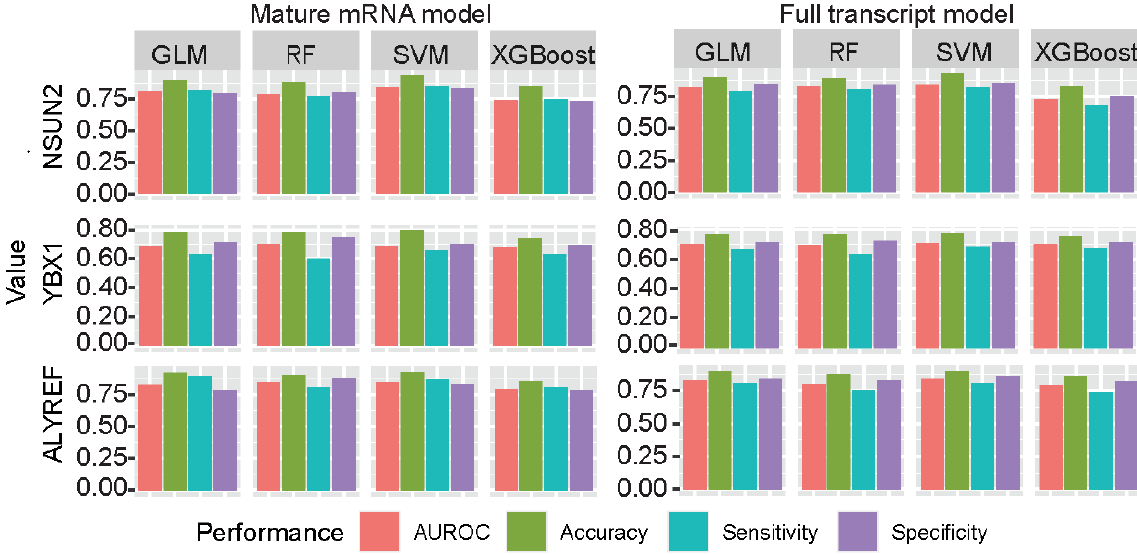
Figure 4. Performance analysis on different machine learning algorithms . SVM represents for sup- port vector machine, RF represents for random forest and GLMs represent for generalize linear model.